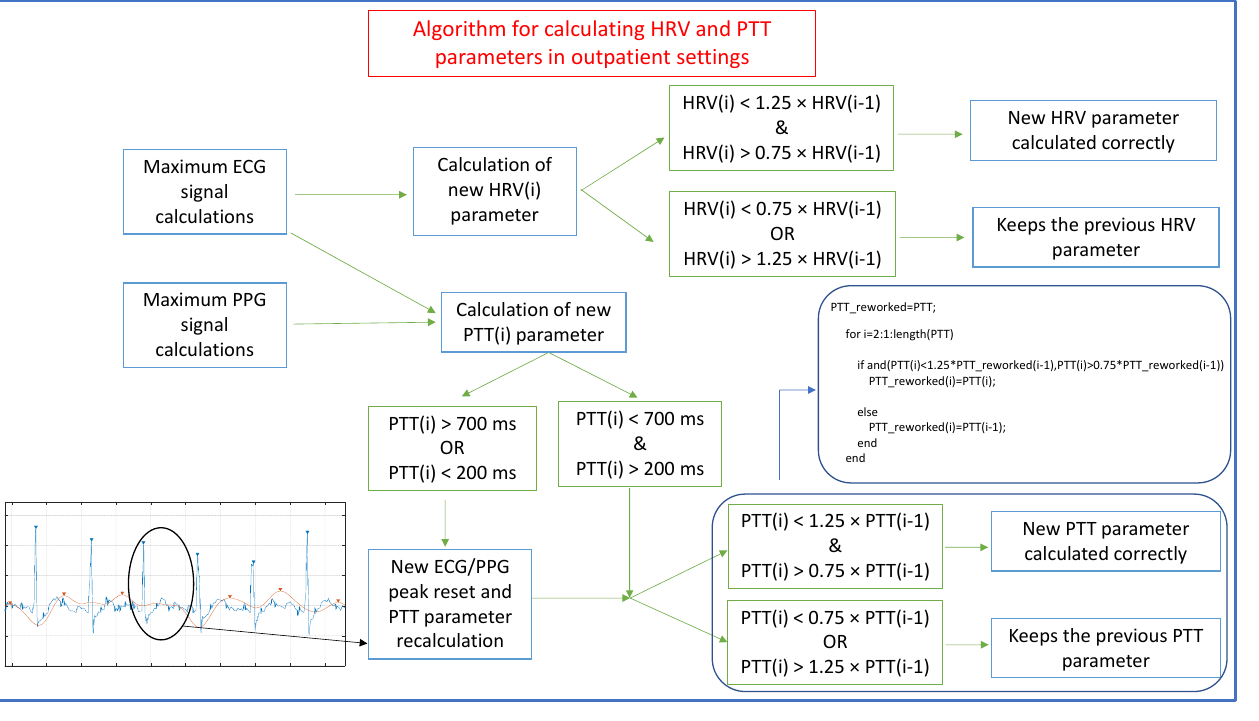
Figure 11. Schematic of the algorithm for the calculation of the HRV and PTT parameters in the ambulatory validation of the monitoring system. The lower left corner shows an example where a systolic peak is not detected in the PPG signal and therefore a local readjustment of the ECG (blue) and PPG (red) peaks is necessary.